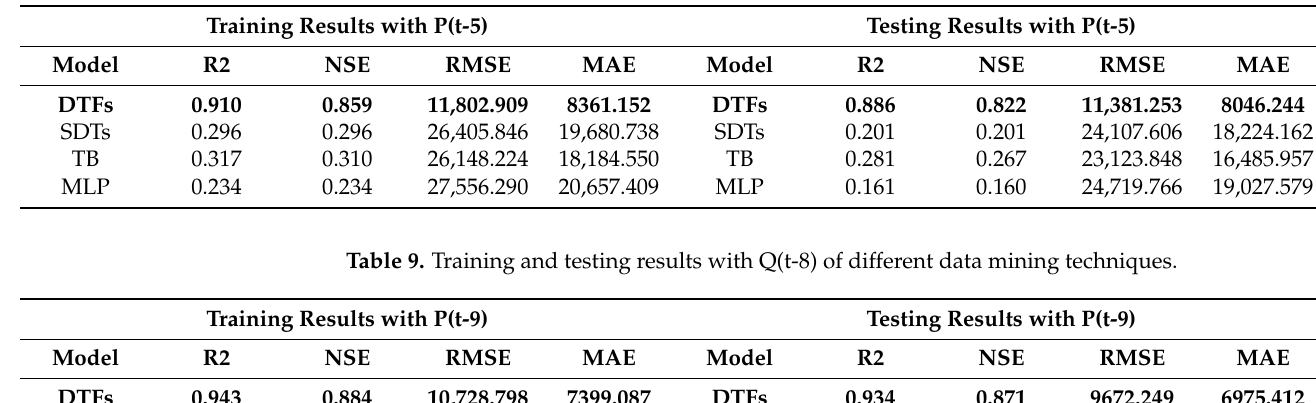
Table 8. Training and testing results with Q(t-5) of different data mining techniques.